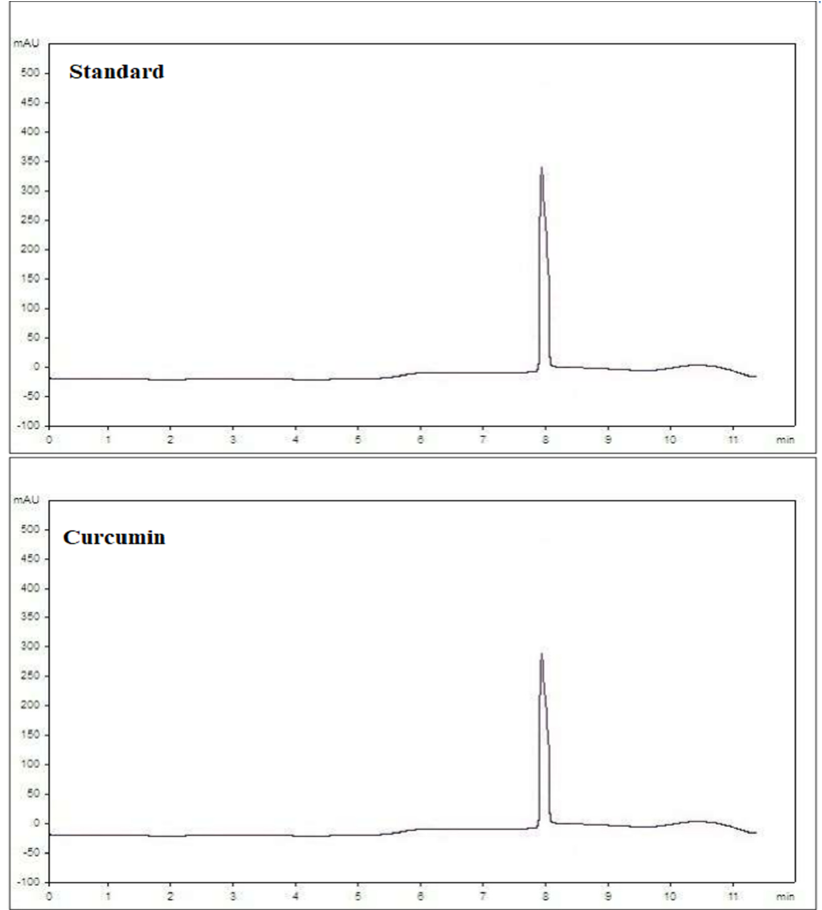
Figure 1. HPLC chromatogram of curcumin isolated from turmeric root compared to standard curcumin.